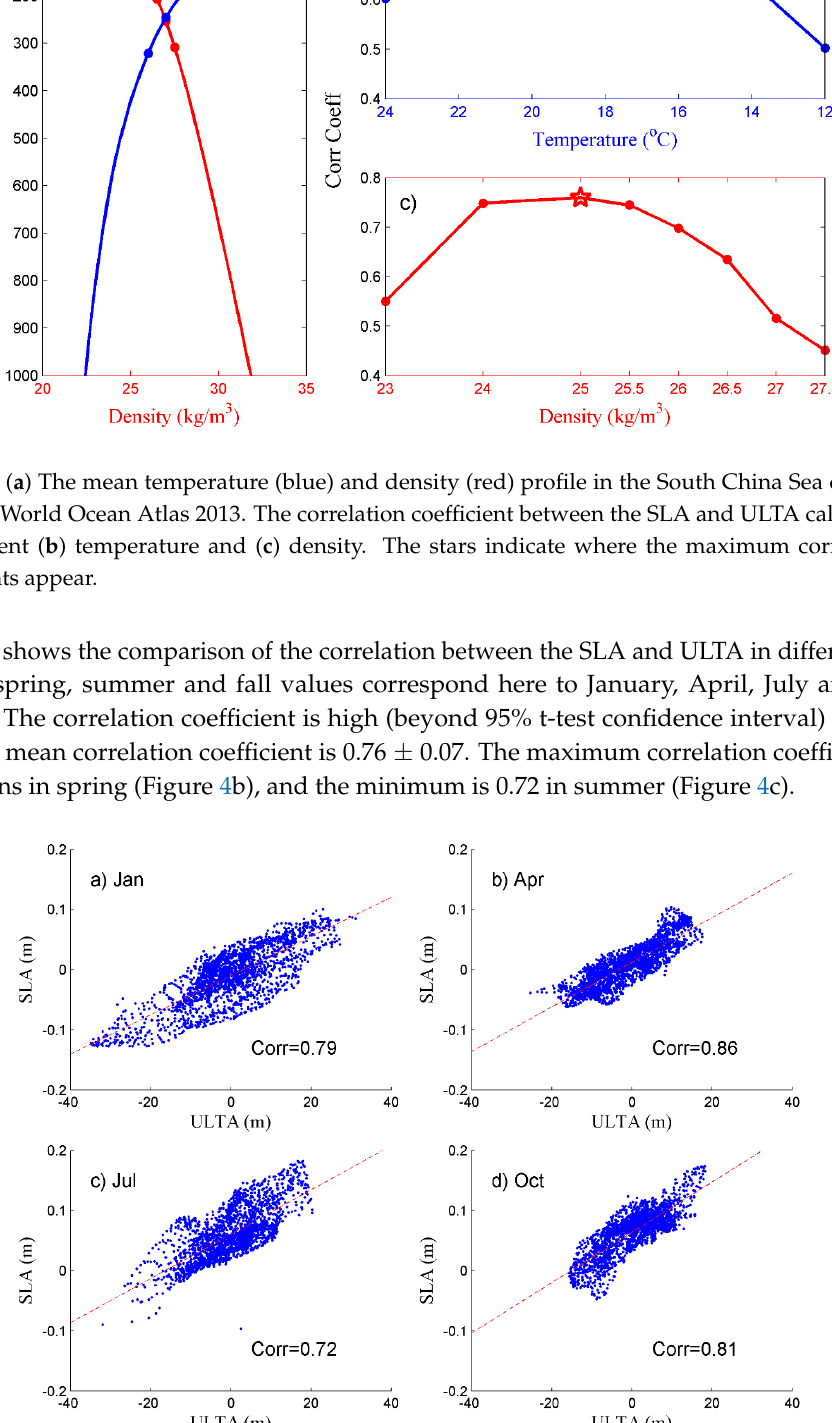
Figure 5. Climatological mean ( a ) ULT (CI: 5 m) and ( b )  (×10 − 3 ) in the South China Sea derived from the World Ocean Atlas 2013. The first row of Figure 6 shows the climatological seasonal variation of  , SLA. In winter,  is negative in most of the South China Sea, and reaches a minimum in the northeastern South China Sea. This is mainly due to the reinforcement of the cold eddy northwest of the Luzon Island. 